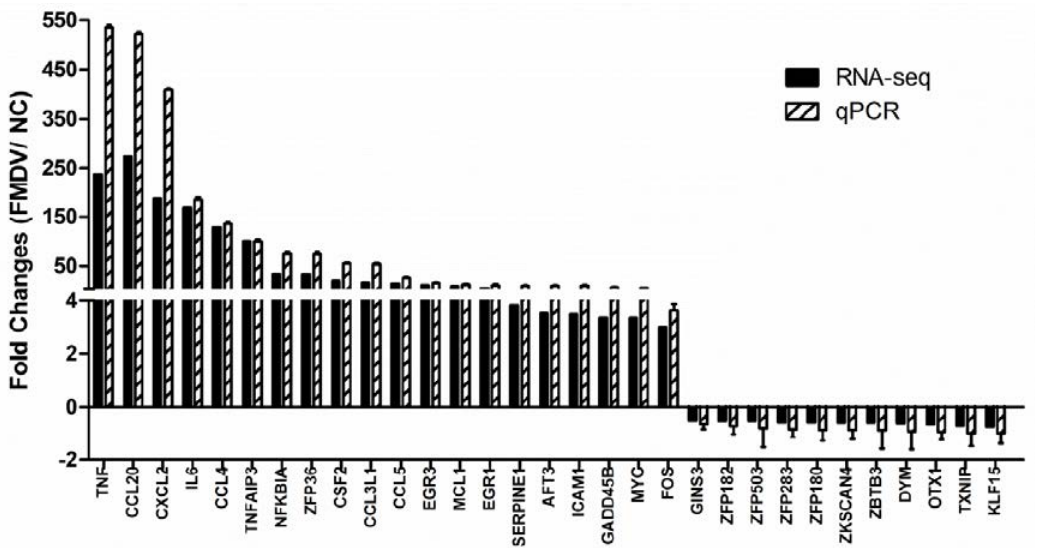
Figure 4. Verification of RNA-seq-detected DEGs with RT-qPCR. PK-15 cells were infected with FMDV (MOI 0.1) for 1 h and then RT-qPCR was performed to detect the relative expression of selected DEGs. The x -axis indicates the names of detected genes and the y -axis represents the fold changes after FMDV infection, β -Actin was used as an internal control. Table 4. Gene ontology (GO) analysis of immune-related DEGs.